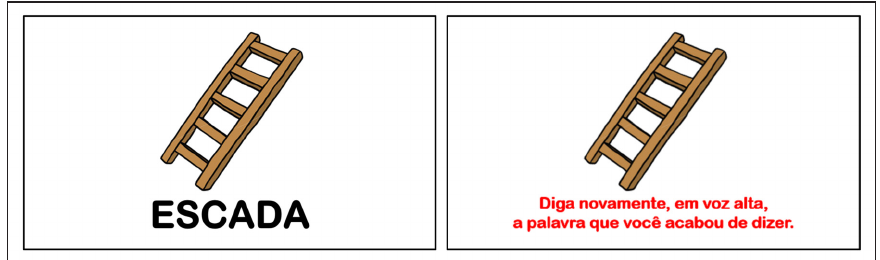
Figure 1: Example of slides used for data